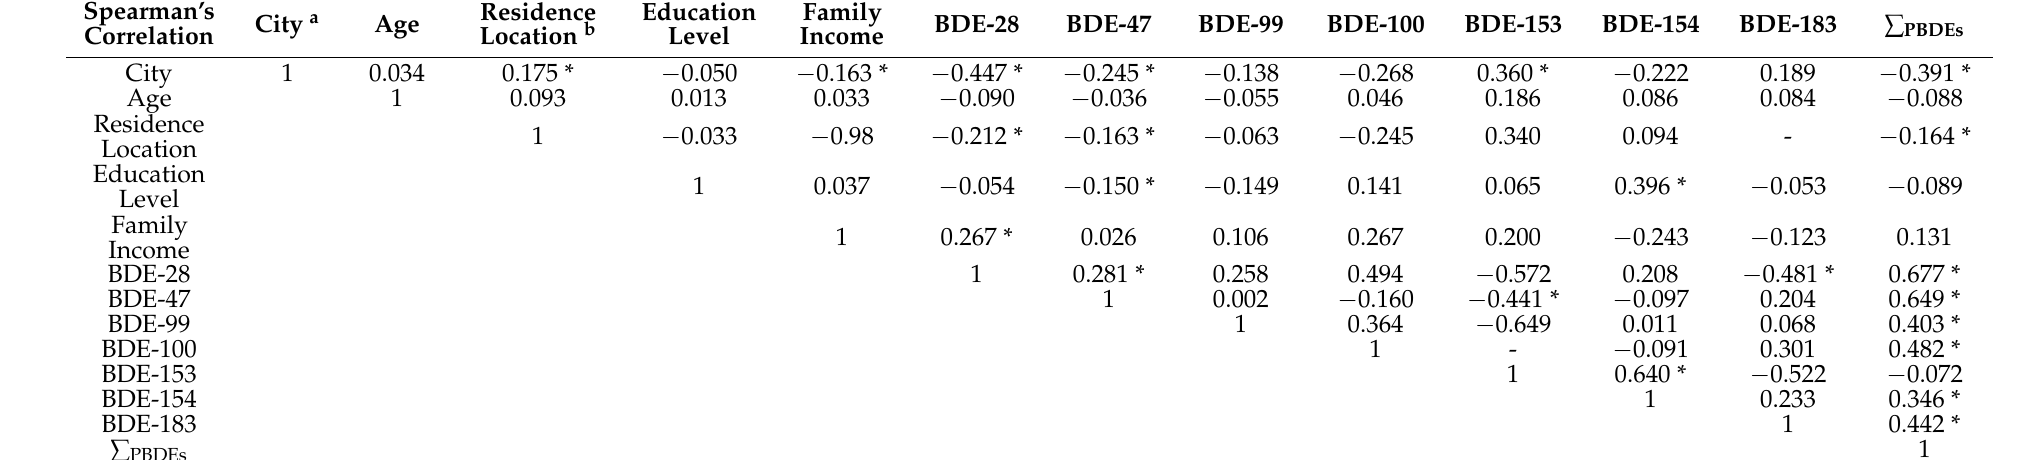
Table 3. Spearman’s correlation coefficient to assess the interfering factors in the infant exposure to PBDEs via breast milk